Question: What visual encoding does this figure use to show its data?
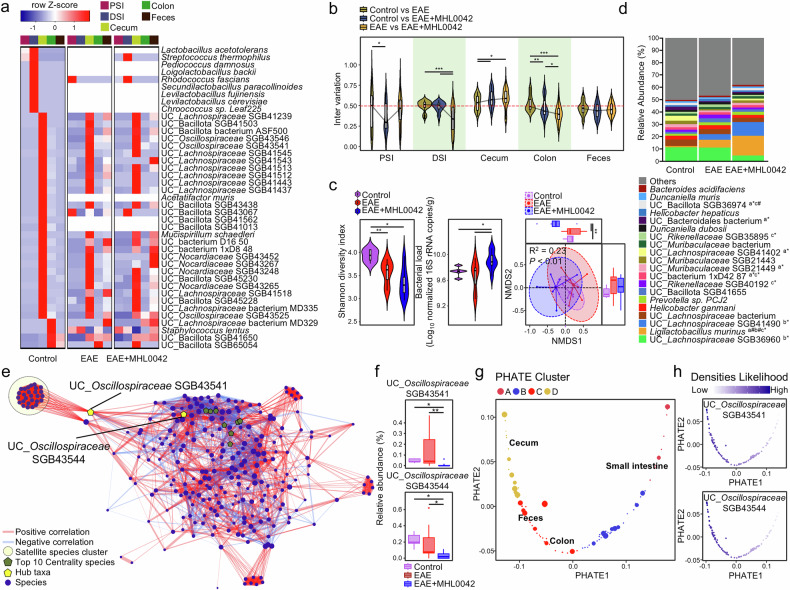
Answer: bar